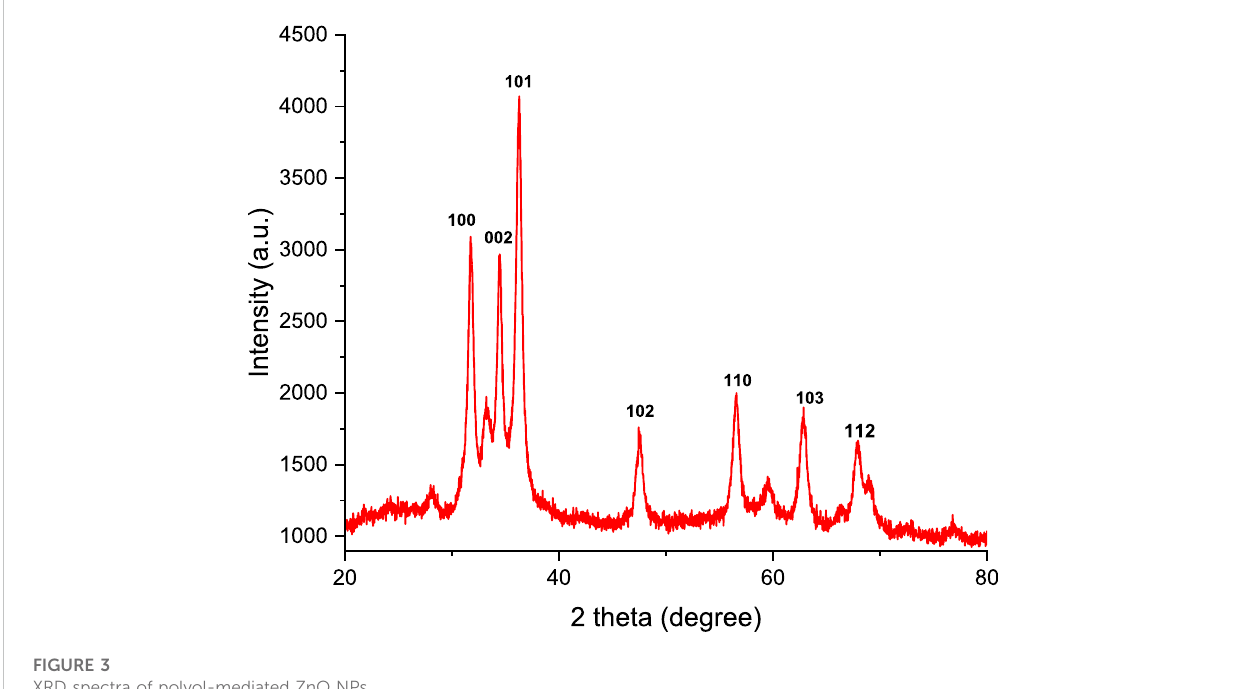
FIGURE 3 XRD spectra of polyol-mediated ZnO NPs.